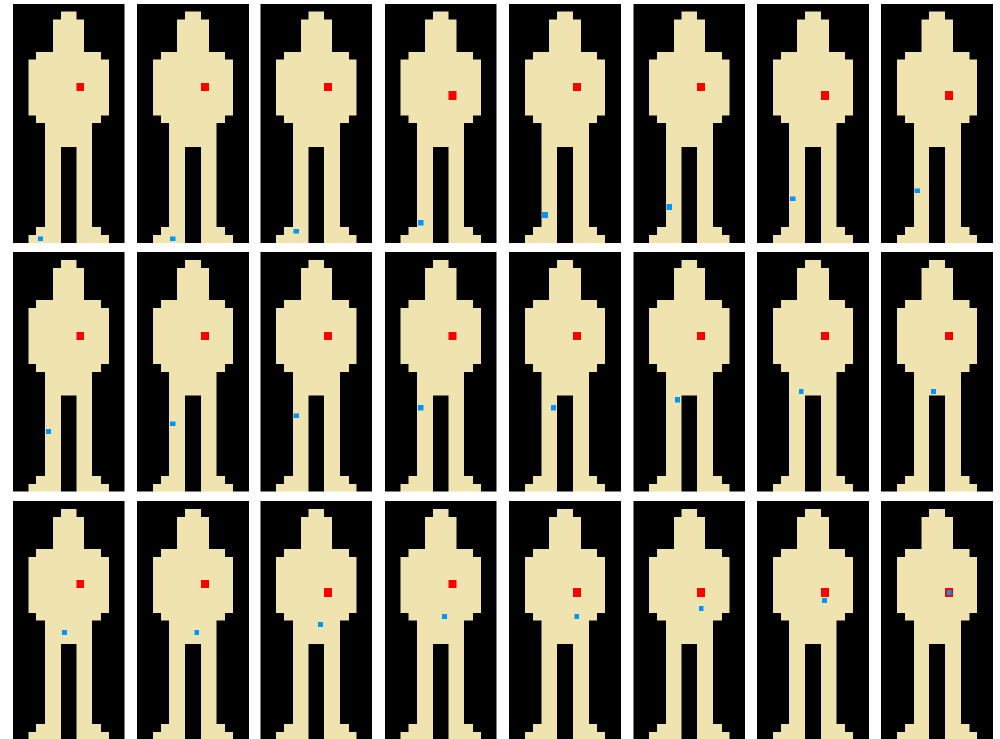
Figure 4. Example of behaviour after 10,000 epochs for training a camera agent (blue pixel) to reach a specific location (blood pixel) through Q-Learning. First state corresponds to upper left image and increases to the right.